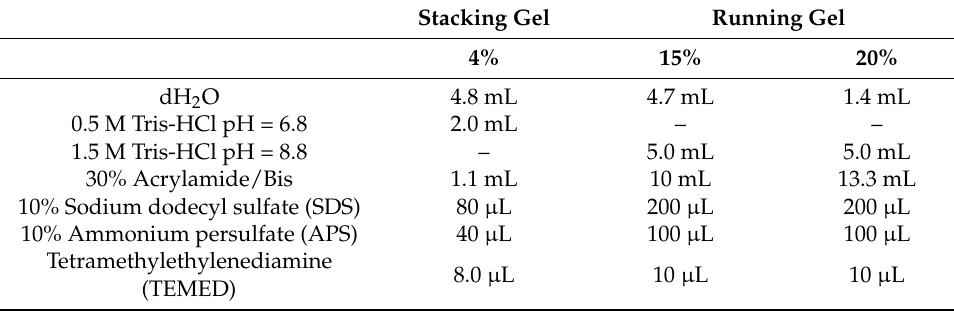
Table 4. Recipes of single-percentage polyacrylamide gels. Volumes were calculated following Bio-Rad